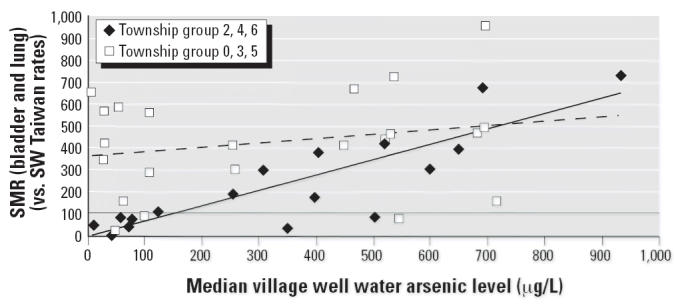
Bladder and lung cancer (combined) SMRs by township group and median village
well water arsenic level (μg/L). Township group 0, 3, 5 (n = 22): y = 0.200x + 358; R2 = 0.053; p = 0.30. Township group 2, 4, 6 (n = 20): y = 0.704x + 6.26; R2 = 0.748; p = 0.001.